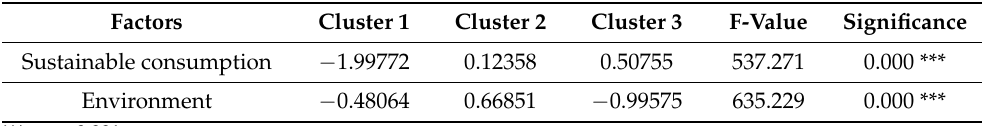
Table 3. Final cluster centers.